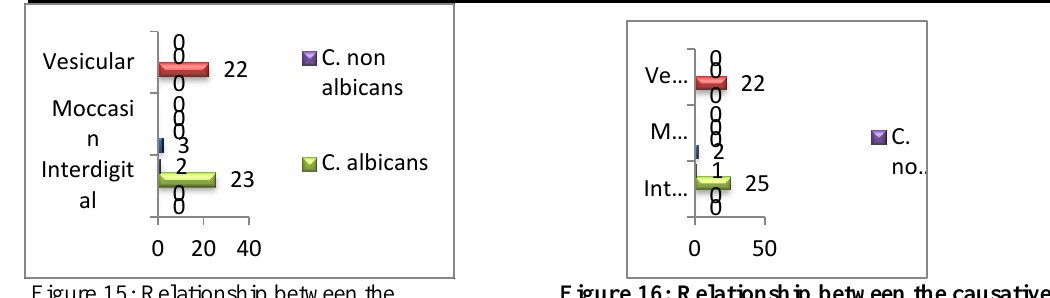
Figure 15: Relationship between the Figure 16: Relationship between the causative fungi and the types of tinea pedis in diabetics. fungi and the types of tinea pedis in non-diabetics . Table (12):relationship between type and causative fungi in non-diabetic, diabetic cases and whole sample